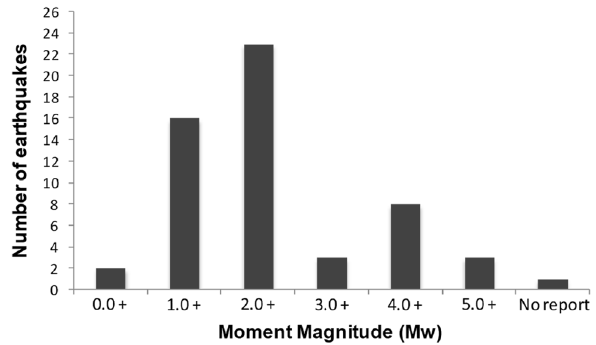
Fig. 11 Magnitude variation of local earthquakes in Peninsular Malaysia during the period 1922–2020. Note: Created with MS